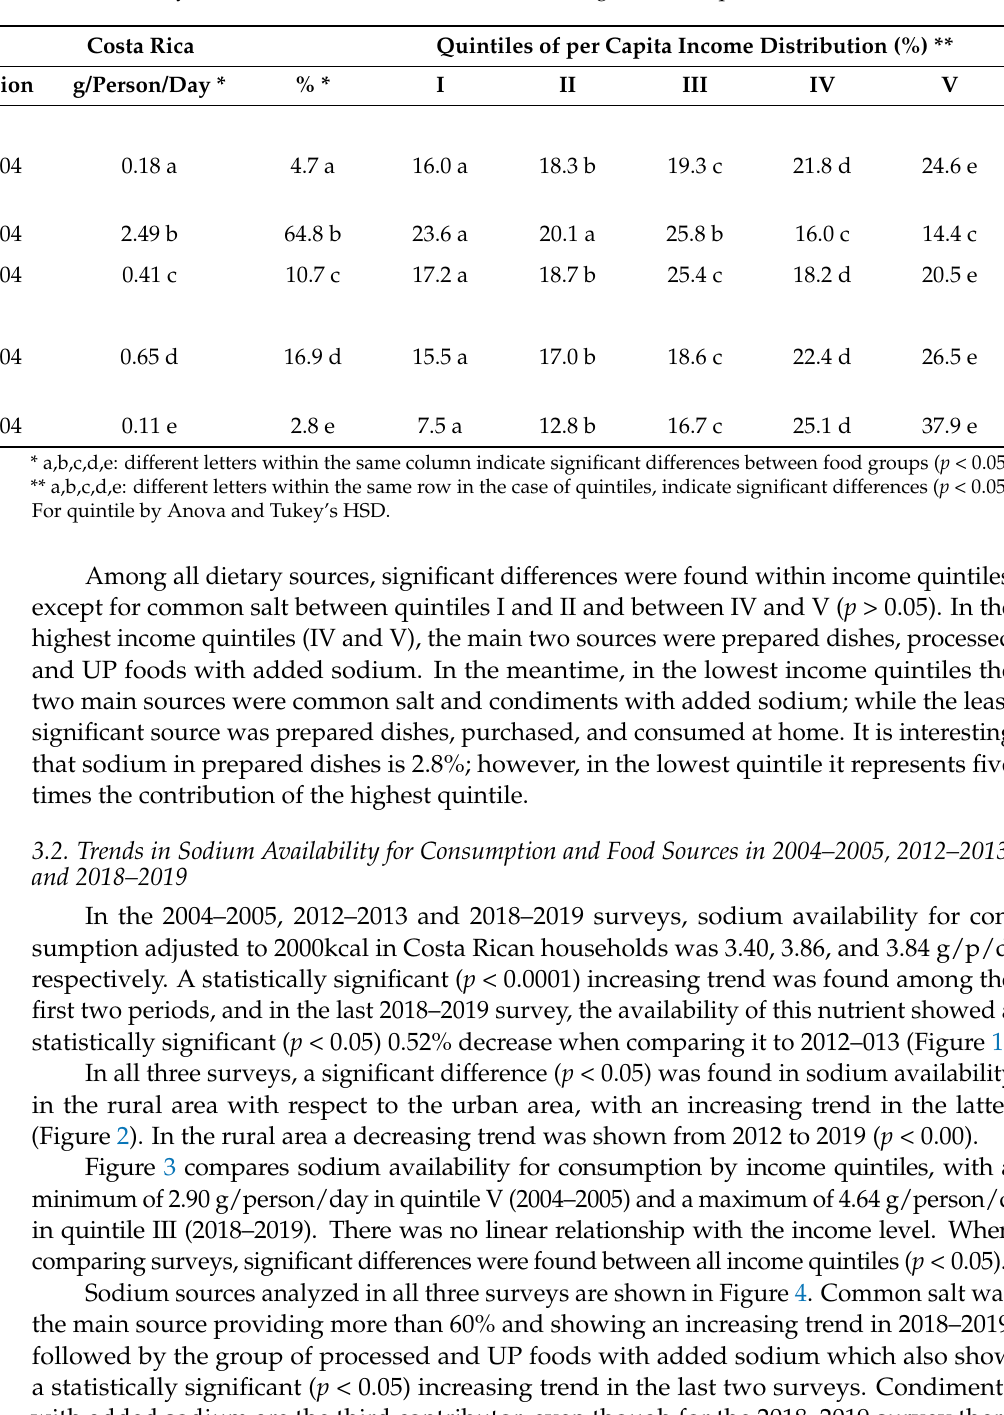
Table 3. Dietary sources of sodium in households according to income quintile, Costa Rica,